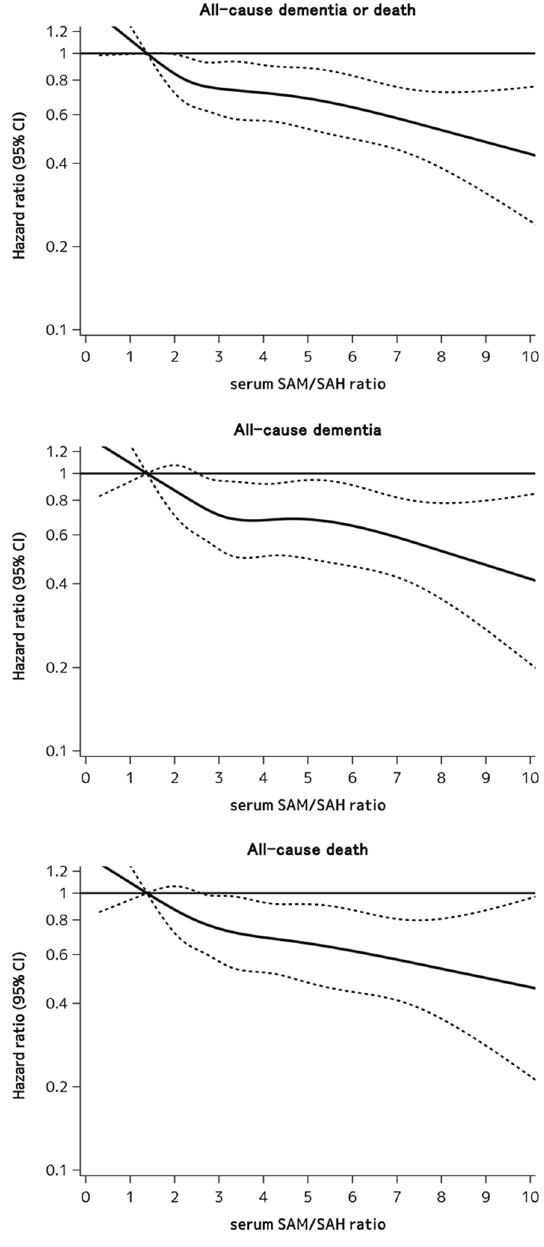
Figure 1. Restricted cubic spline for the association between the serum SAM/SAH ratio and risk of all- cause dementia or death. Solid lines represent the hazard ratio, and dashed lines represent the 95% CI of the hazard ratio. Knots were placed at the 5th, 25th, 50th, 75th and 95th percentiles (1.33, 2.33, 3.07, 4.53, and 7.78, respectively) of the serum SAM/SAH ratio. A reference point was set at the 5th percentile (1.33). The risk estimates were adjusted for age, sex, education, hypertension, diabetes mellitus, serum total cholesterol, body mass index, history of stroke, current smoking, regular exercise and use of vitamin B supplements. SAM, s-adenosylmethionine; SAH, s-adenosylhomocysteine; CI, confidence